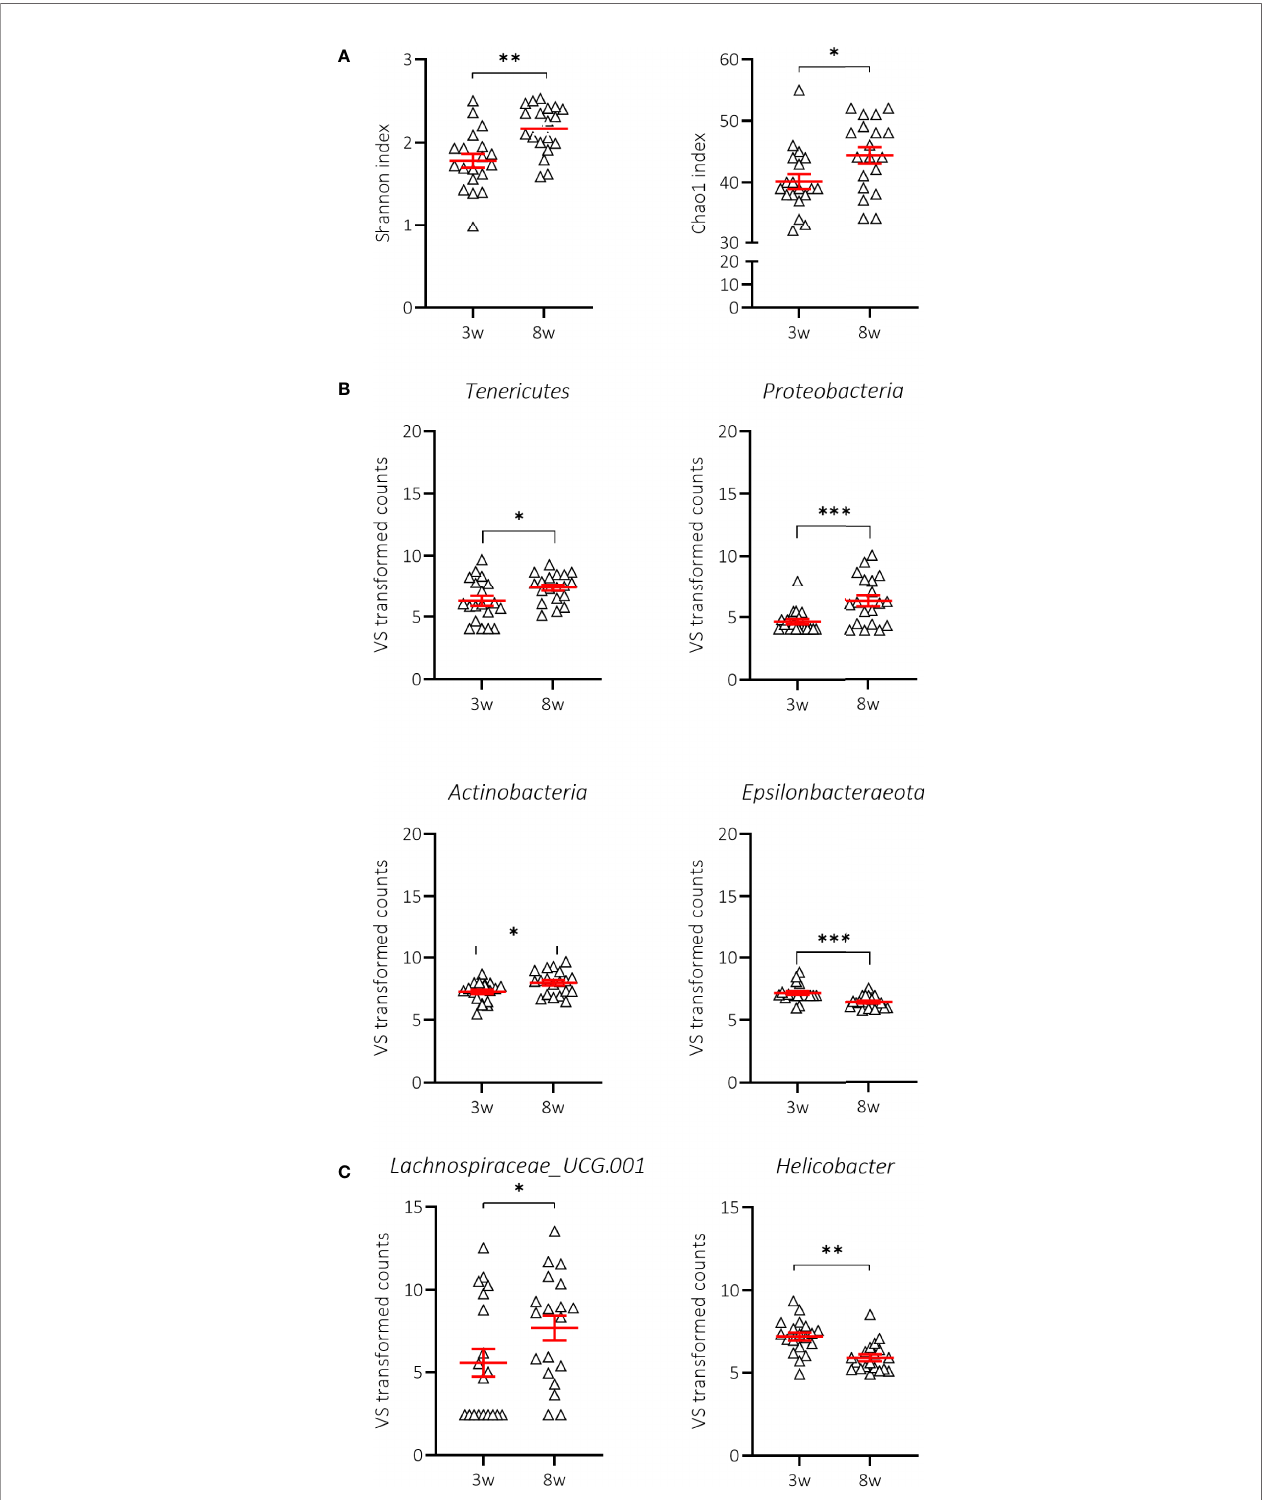
FIGURE 5 | Change in alpha-diversity and taxa abundances of NOD mice receiving normal chow (NC). Changes in Shannon and Chao1 indices (A) , phyla (B) and genera (C) are shown for female NOD mice receiving normal chow (NC) (N = 38 paired samples). Symbols (N = 9-19) represent individual mice, and the line re fl ects the group mean with SEM. *P ≤ 0.05; **P ≤ 0.01; ***P ≤